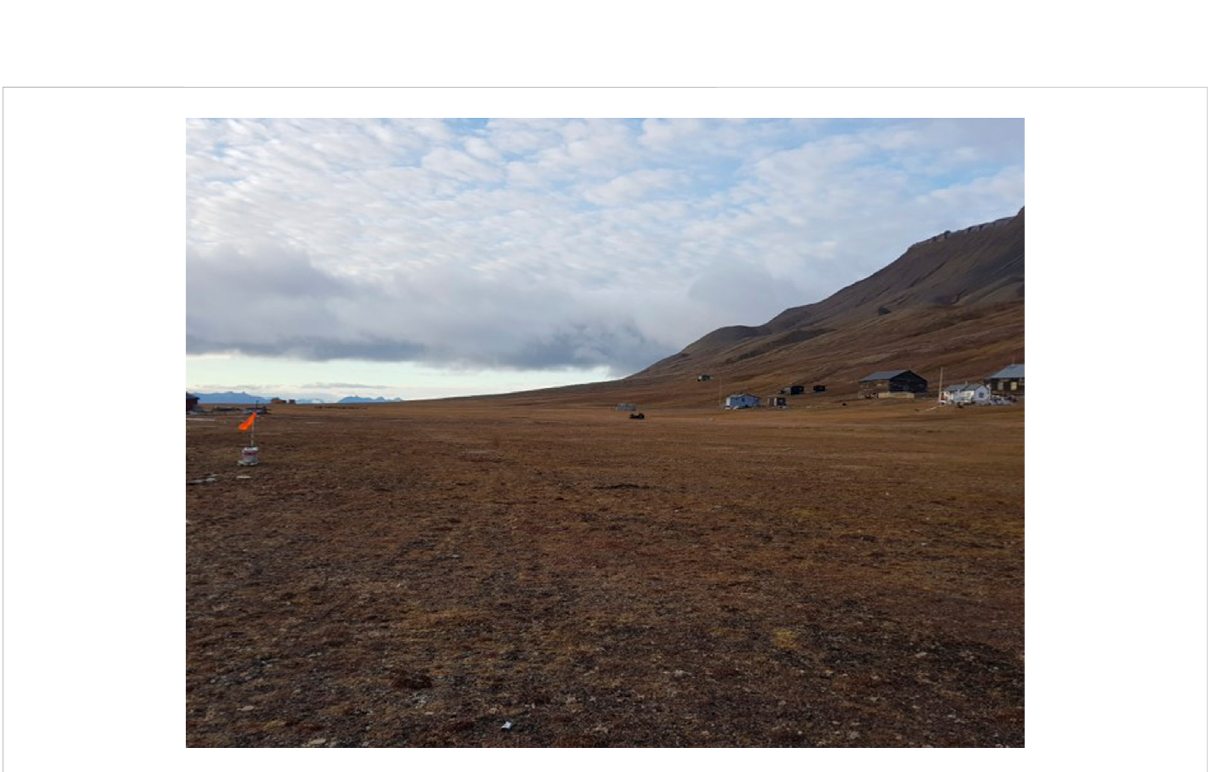
FIGURE 4 The beach at Hiorthhamn, Svalbard, with placing of monitoring station. Photo: Lena Rubensdotter, NGU & UNIS 2020.